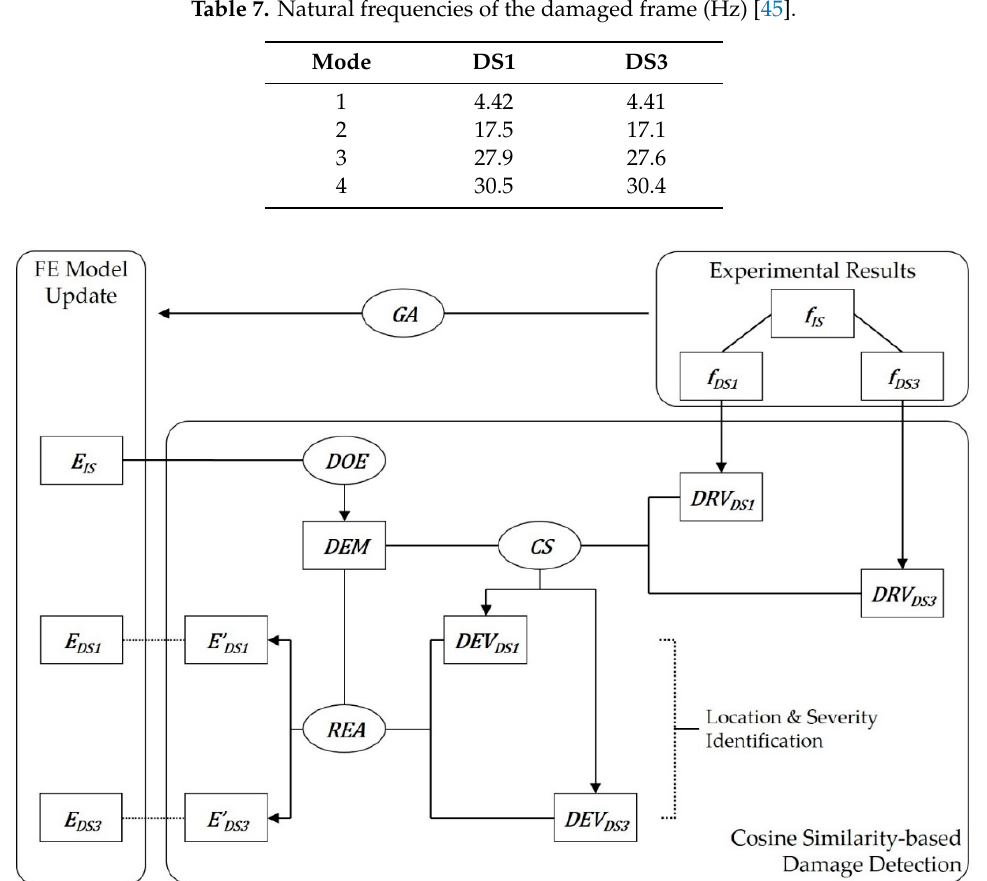
Table 7. Natural frequencies of the damaged frame (Hz) [45].